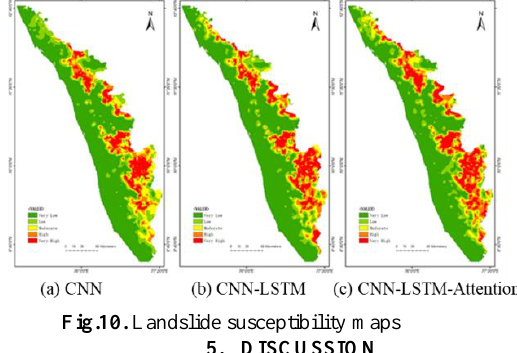
Fig.10. Landslide susceptibility